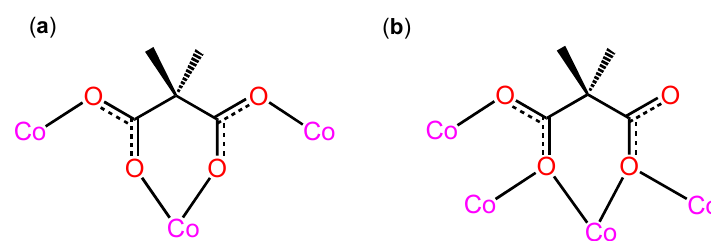
Scheme 1. The Schematic representation of the temperature-controlled assembly/reassembly of compounds 1 and 2 .